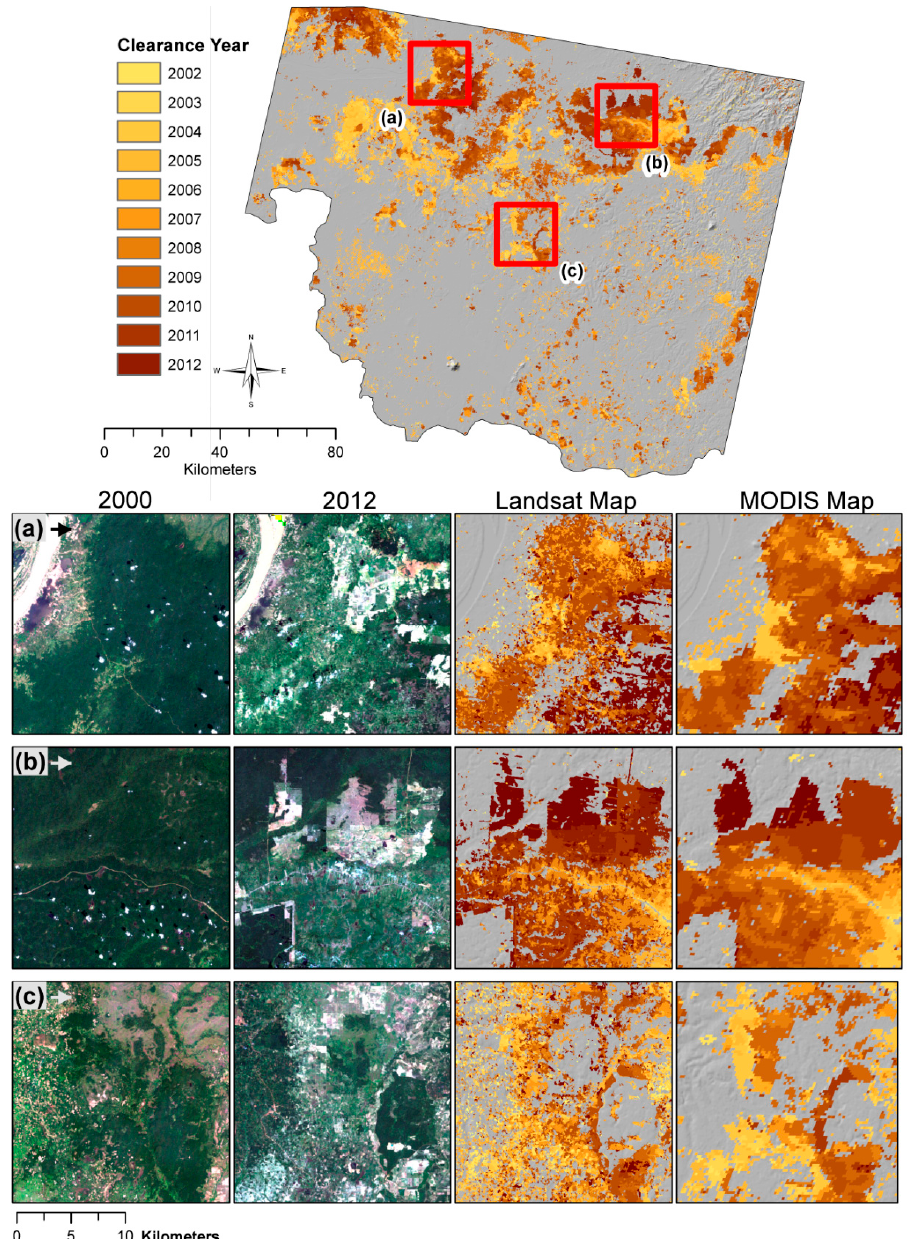
Figure 7. Comparison of Landsat reference map and MODIS forest clearance map using the bmag + slp forest-type specific models, and Land Surface Water Index (LSWI) time series. Landsat imagery (RGB = bands 3, 2, and 1) from year 2000 and 2012 are shown for three study area subsets showing; clearing in evergreen forest by mostly smallholders ( a ); large-scale clearing of evergreen forest for plantations ( b ); and clearing of evergreen, mixed and dry-deciduous forest ( c ).